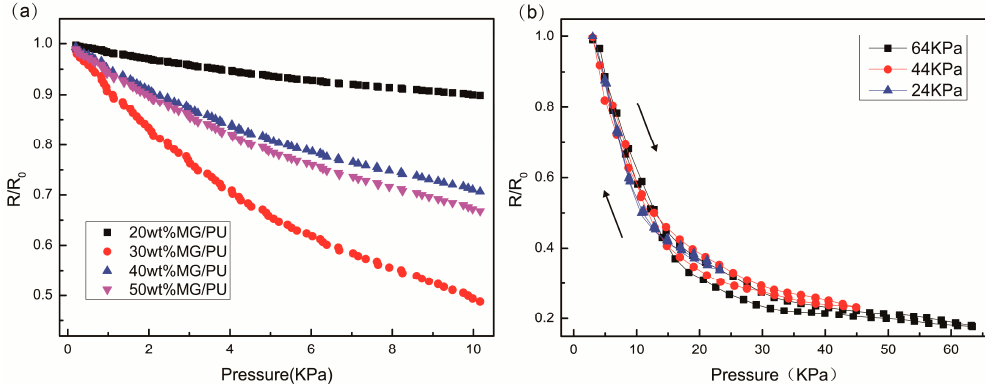
Figure 8. ( a ) The resistivity change of MG/PU composite films with applied pressure; ( b ) Hysteresis curves of the 30 wt % MG/PU composite films under different loading-unloading pressure cycles.